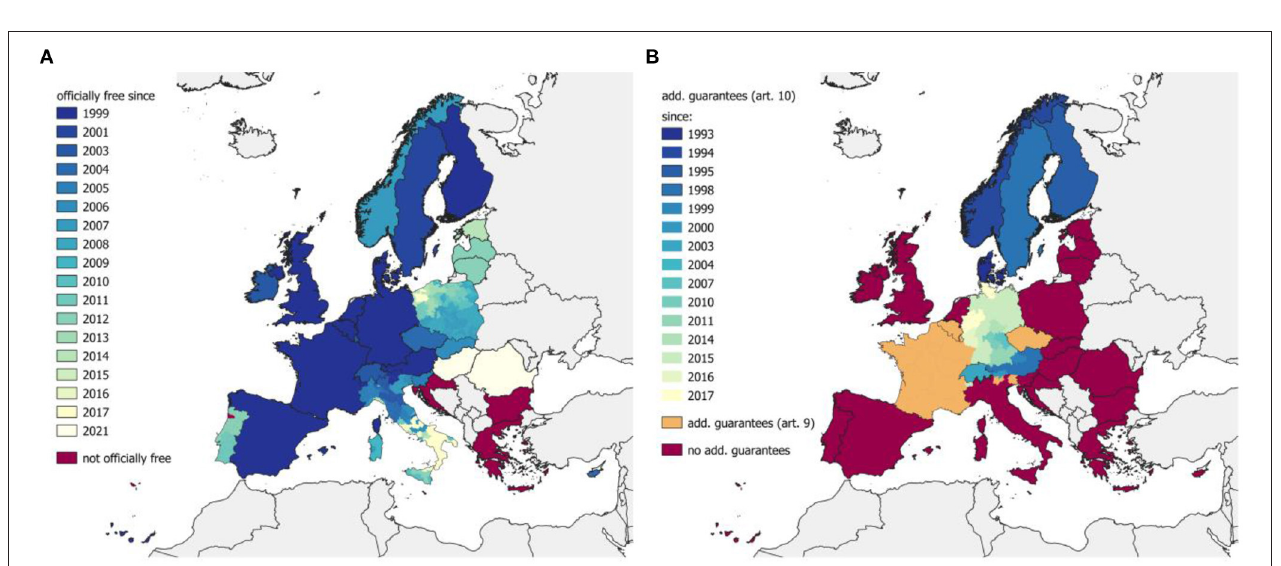
FIGURE 2 | Historical development of freedom of EBL (A) and IBR/IPV (B) . The EU grants the member states an officially EBL-free status and additional guarantees for IBR based on Council Directive 64/432/EEC. The concerned member states are listed in the Commission Decision 2003/467/EC (31) [since 2003, before that in 1999/465/EC (32)] for EBL and in Commission Decision 2004/558/EC (33) [since 2004, before that in 93/42/EEC (34)]. Switzerland and Norway have separate agreements. Information about the EBL status of Switzerland was collected from Appendix 2(I)(B)(5) of Annex 11 to the Agreement between the EU and the Swiss Confederation on trade in Agricultural Products (2004/78/EC) (35) and Norway on EFTA Surveillance Authority Decision 28/07/COL (36). IBR/IPV information for Switzerland was obtained from Appendix 2(I)(B)(6) of Annex 11 to the Agreement between the EU and the Swiss Confederation on trade in Agricultural Products (2004/78/EC) ( 35) and Norway on EFTA Surveillance Authority Decision 74/94/COL (37).